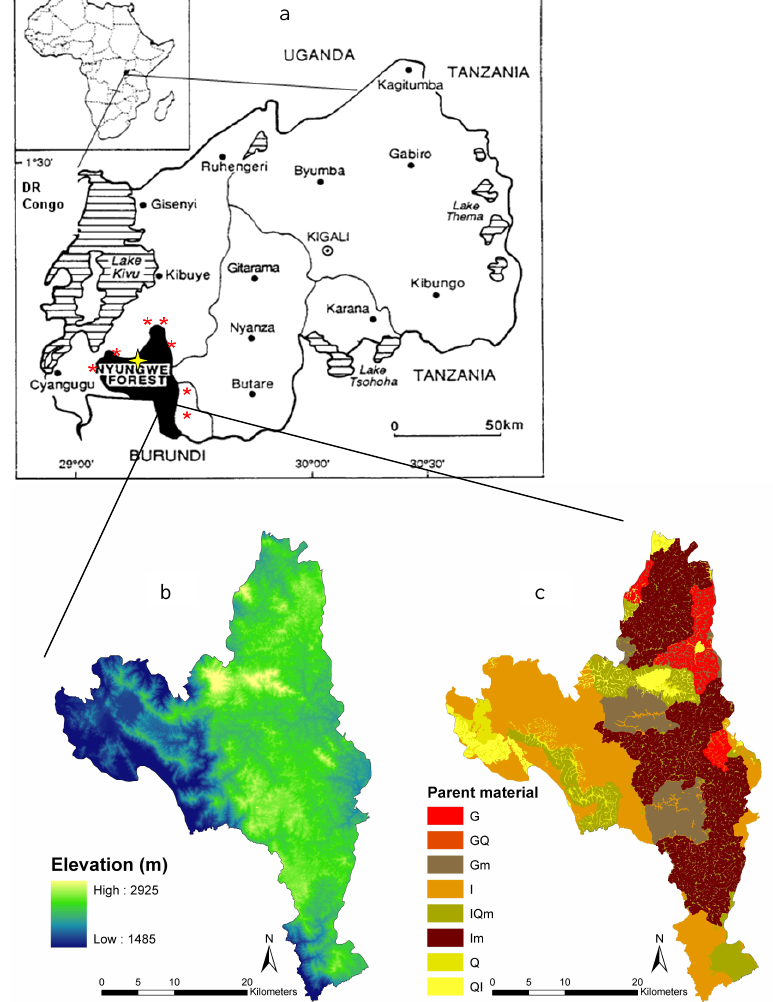
Fig. 1. Location of the Nyungwe forest in southwestern Rwanda; seven climate stations around the forest are shown by red stars; the recent climate station in the Nyungwe forest is shown by a yellow star (a) , elevation map (b) and parent material map of the Nyungwe forest: Q = quartzite; QI = quartzite intercalated with schists; IQm = quartzite intercalated with micaschists; GQ = granitic and quartzitic rocks; G = acid rocks (granite); Gm = micaceous acid rocks (granitoide); Im = micaschists; I = schists (c)